Question: State the chart type depicted above.
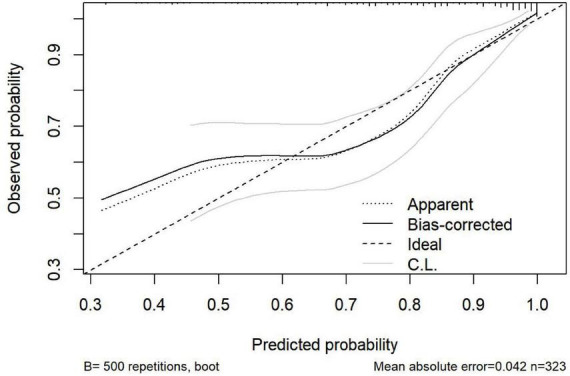
Answer: line